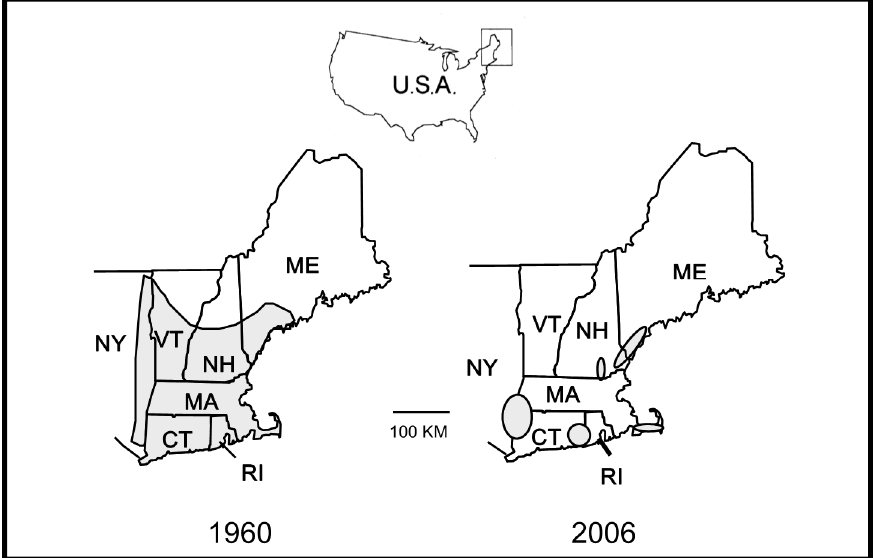
Figure 2. Historic and estimated range of New England cottontails in seven states within the northeastern United States. Populations in Vermont (VT) have been extirpated [22].